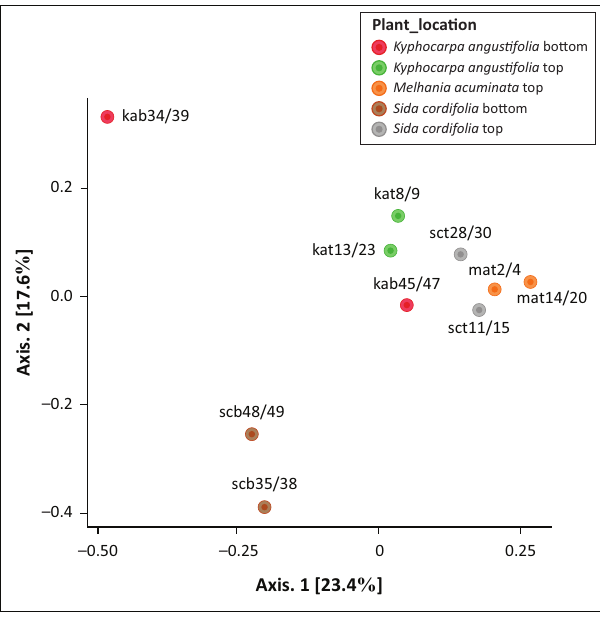
FIG URE 4: Principal coordinates analysis of the rhizosphere microbiome for Kyphocarpa angustifolia and Sida cordifolia from the Sterkspruit site (bottom) and K. angustifolia , Melhania acuminata and S. cordifolia from the Clovelly site (top).